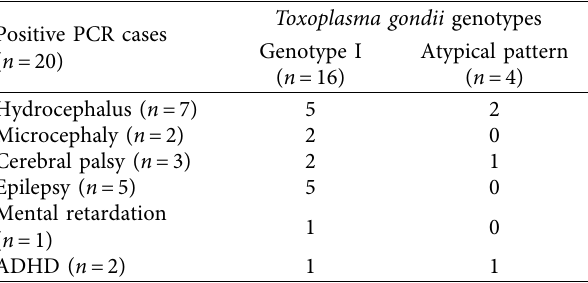
Table 4: Toxoplasma gondii GRA6-RFLP genotypes in relation to neurodevelopmental